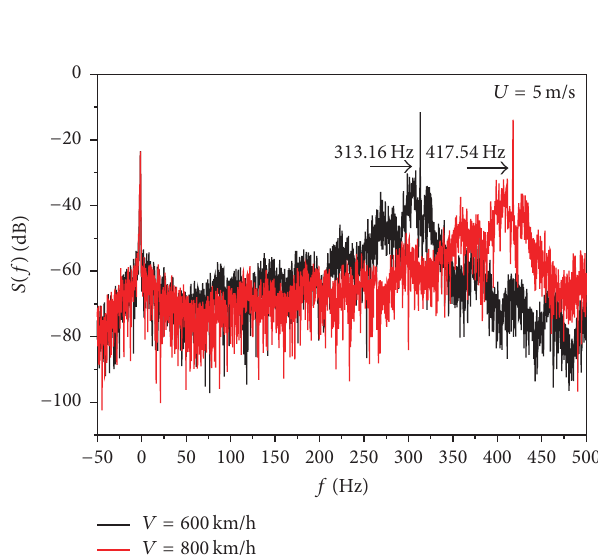
Figure 8: Doppler spectra of the target flying at different speed.